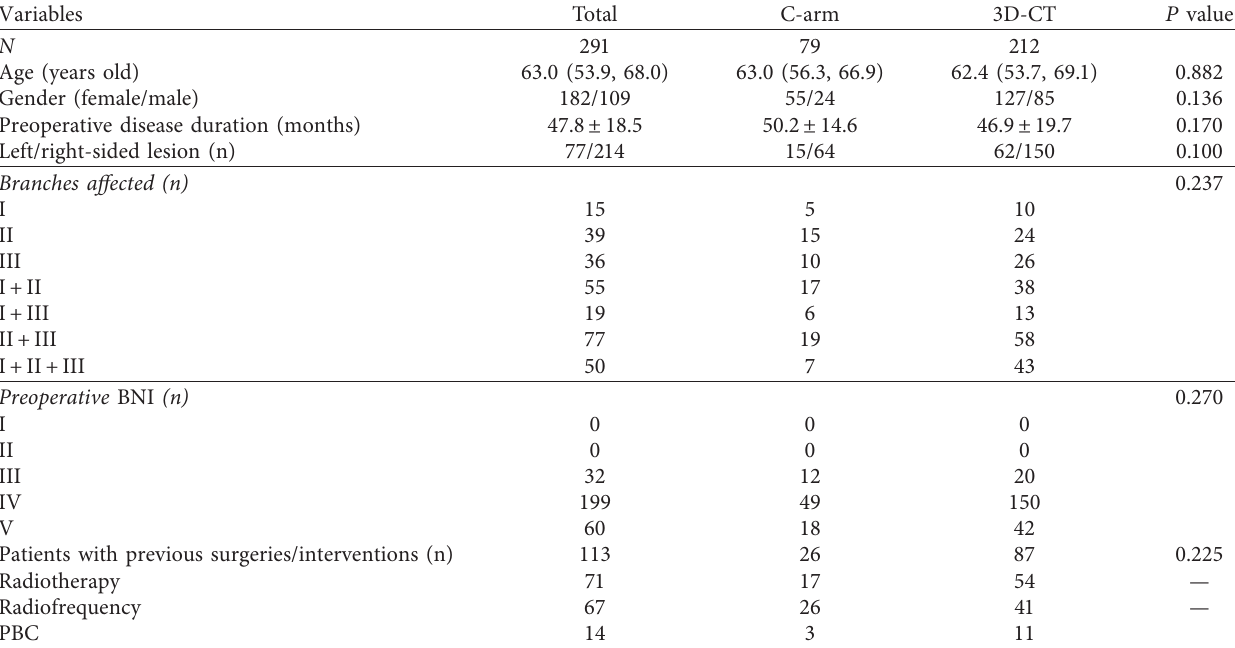
Table 1: Demographic data and preoperative conditions of the included patients.